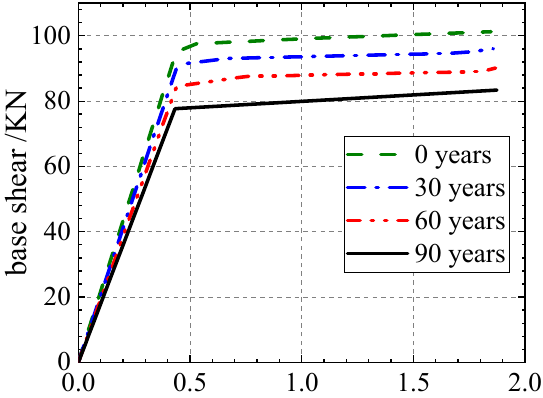
Figure 20. Pushover curves of the transmission tower under different corrosion ages. Table 4. Index limits for each damage mode of the transmission tower.